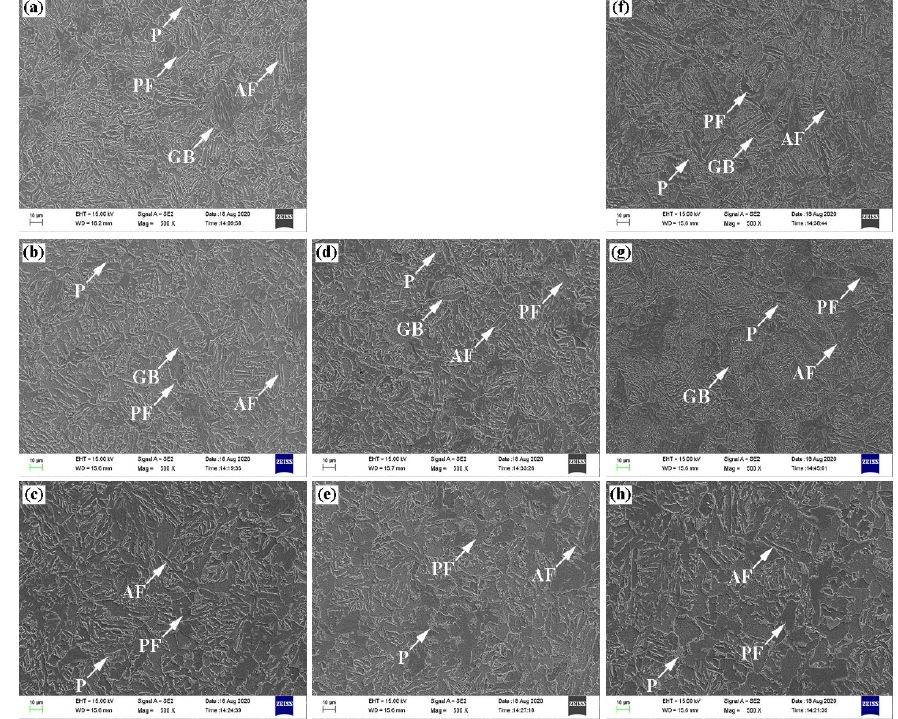
Figure 5. SEM microstructure of steel plate at the different temperature measurement points. Images ( a – h ) demonstrate the microstructure at points P1–P8,